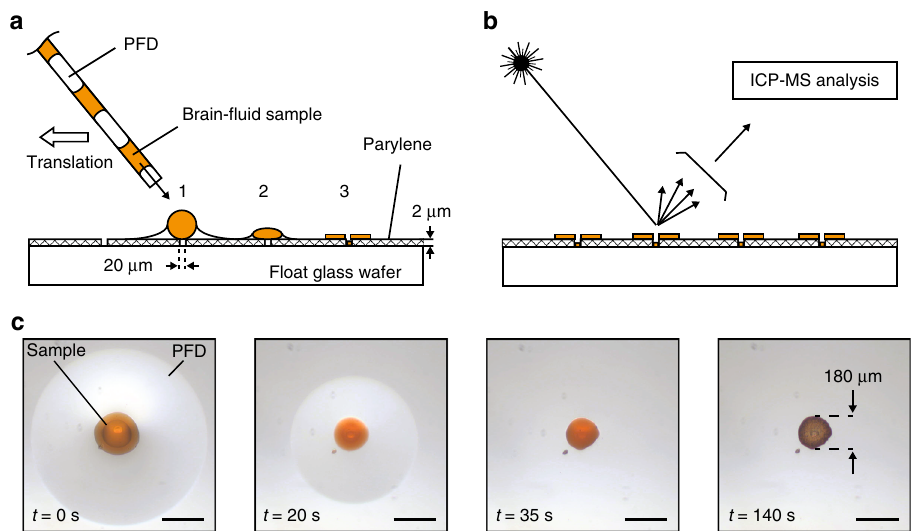
Fig. 5 Droplet distribution procedure and analysis on the parylene base plate. a The brain- fl uid samples are distributed on 20 μ m drilled holes in a 2 μ m thick parylene layer. The fl oat glass wafer is hydrophilic and tends to fi x the aqueous samples in position while the hydrophobic parylene tends to extract away the PFD oil. b After drying, the brain- fl uid samples are laser ablated and analyzed using ICP-MS. c Drying sequence which shows the evolution of a red-colored water droplet and the adjacent PFD carrier phase (scale bar = 200 μ